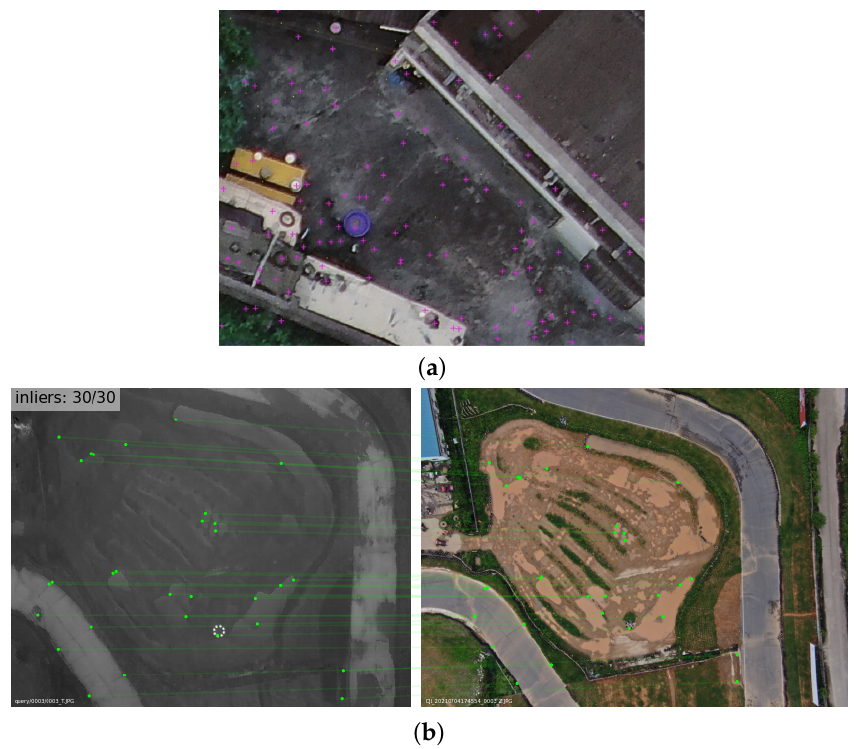
Figure 7. Manual annotation of the thermal images. ( a ) The markers on the bridge image. ( b ) Labeling the tie points between the bridge and the thermal